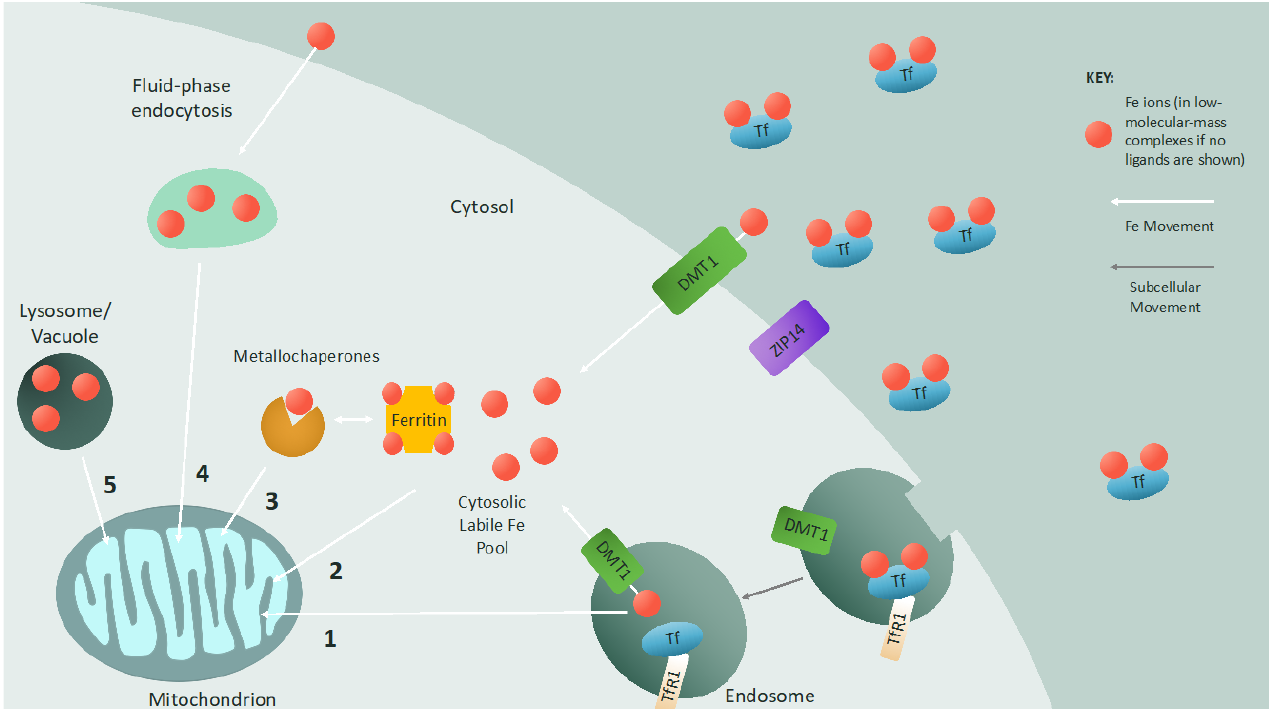
Figure 1. Iron delivery to the mitochondrion: Iron is imported into cells by either endocytosis (transferrin-bound iron) or plasma membrane channels (non-transferrin-bound iron). The metal transporter ZIP14 has been shown to aid in the cellular uptake of both transferrin-bound and non-transferrin-bound iron. When iron-loaded transferrin binds to the transferrin receptor on the cell surface, the protein–receptor complex is endocytosed, and iron is released into the endosome and reduced. This iron can be exported via the endosomal divalent metal transporter (DMT1) to the cytosolic labile iron pool, which consists of iron ions in low-molecular-mass complexes or stored in ferritin. Alternatively, if the endosome contacts the mitochondrion, iron is transferred to the mitochondrion via a “kiss and run” mechanism (1). Non-transferrin-bound iron imported by DMT1 on the cell membrane directly enters the cytosolic labile iron pool as iron chelated by low-molecular-mass molecules or ferritin and can then be imported into mitochondria (2). Metallochaperones such as glutaredoxin can also deliver iron to mitochondria (3). Fluid-phase endocytosis is an additional mechanism to deliver non-transferrin-bound iron to mitochondria (4). In some cases, interactions between mitochondria and lysosomes or vacuoles mediate iron transfer between organelles (5), and there may be a synergistic effect between lysosome/vacuole homeostasis and mitochondrial iron homeostasis. (Tf = transferrin; TfR1 = transferrin receptor 1).